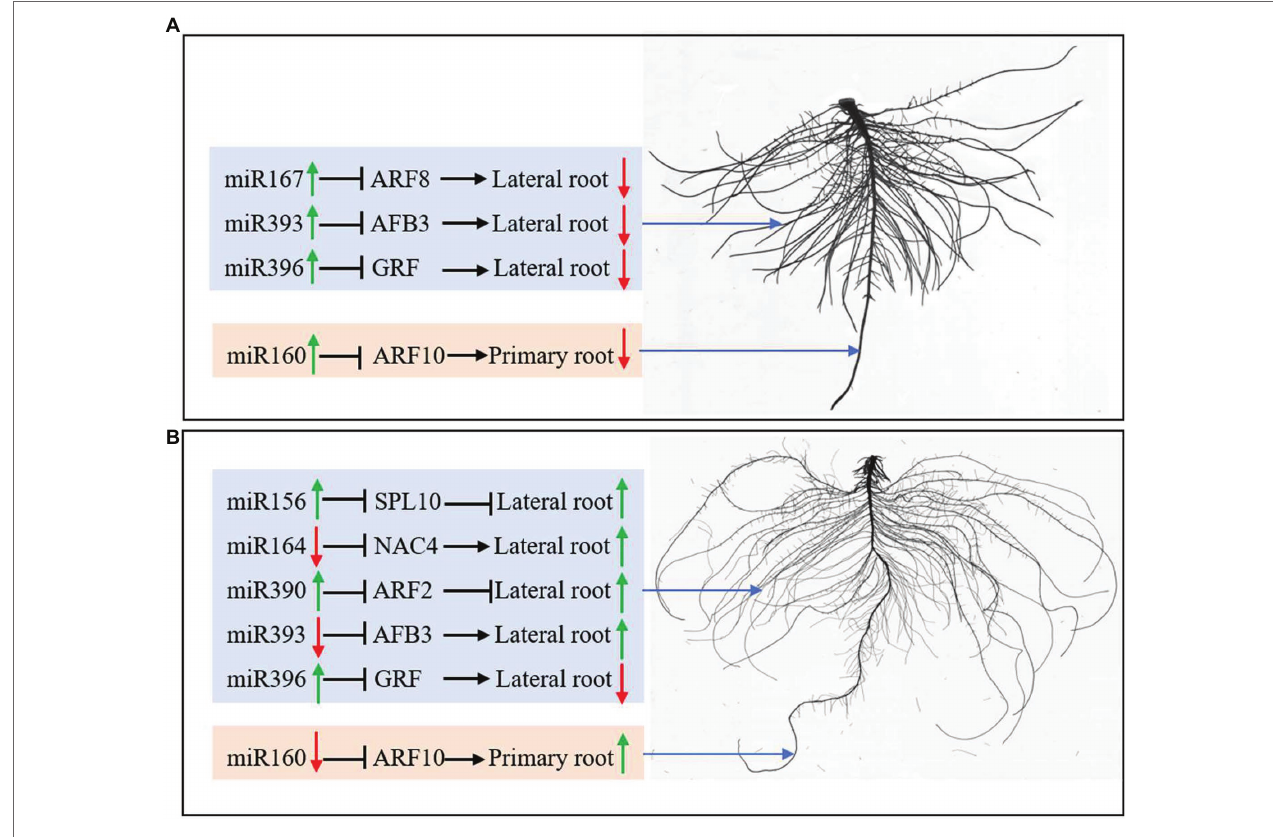
FIGURE 8 | miRNAs regulate root development by controlling protein-coding genes’ expression under N deficiency (A) and K deficiency (B) . The green arrow represents the upregulated expression of miRNAs and the enhanced growth of roots; the red arrow represents the downregulated expression of miRNAs and the inhibited growth of roots. N, nitrogen and K,